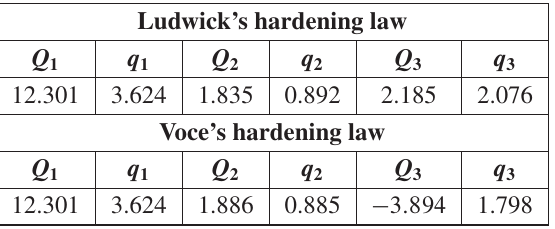
Table 4. Parameters obtained by fitting